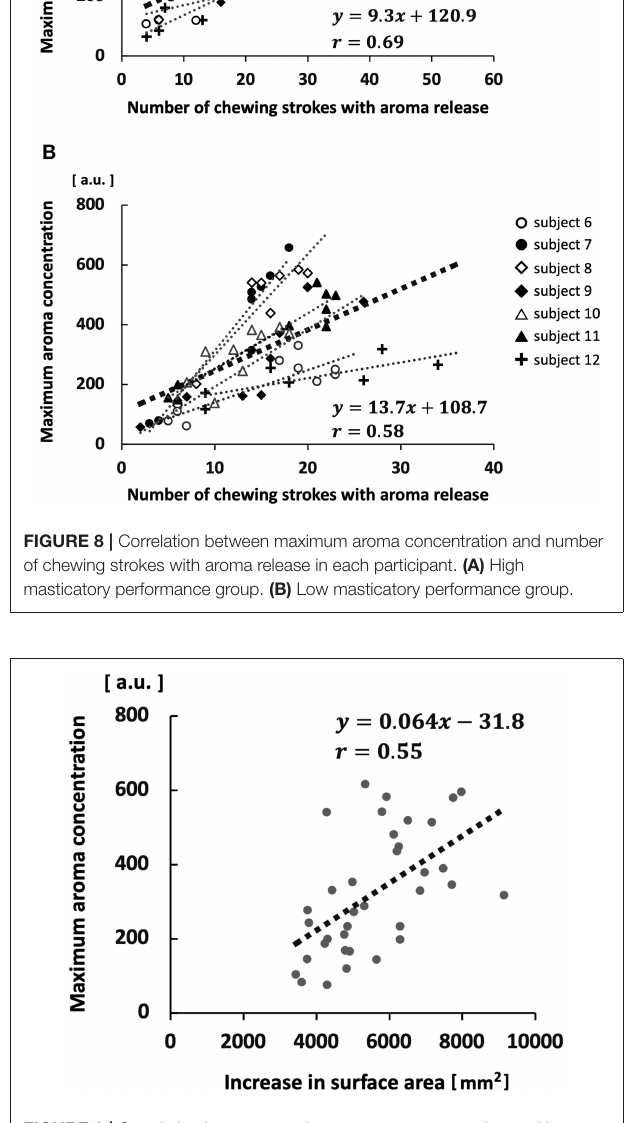
release measurements: masticatory function was measured by indirect evaluation such as electromyography and occlusal force tests, or aroma and masticatory function were measured by different tasks. In this study, masticatory performance was